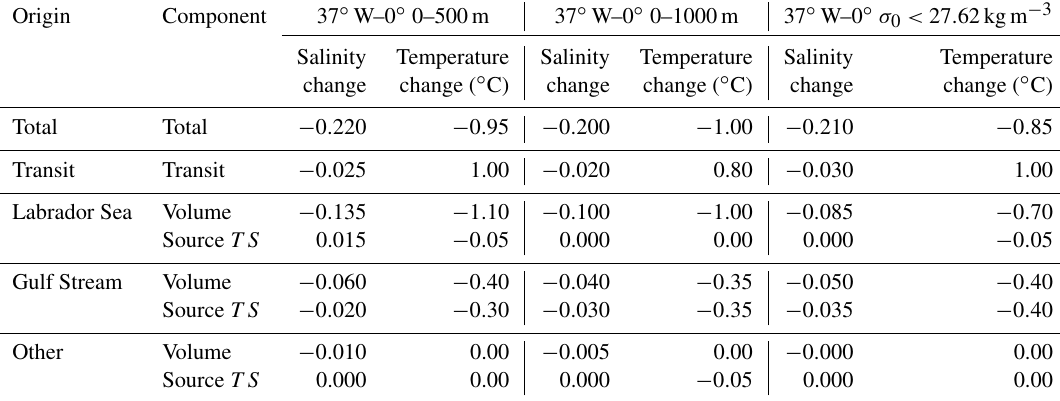
Table 1. Contributions to the freshening and cooling of water crossing OSNAP E in 2016–2017 (peak freshening and cooling) relative to 2011–2012 (the start of the more rapid freshening and cooling). Contributions are listed by the components described in Sect. 4.3 and Fig. 7 for water crossing OSNAP E between 37 ◦ W and 0 ◦ in (1) the top 500m, (2) the top 1000m, and (3) the upper limb ( σ 0 < 27 . 62kgm − 3 ). The largest contribution to both freshening and cooling is made by the changing volume of water of Labrador Sea origin. The single component contributions do not necessarily sum to the total, as the component contributions are not independent (see Eq.